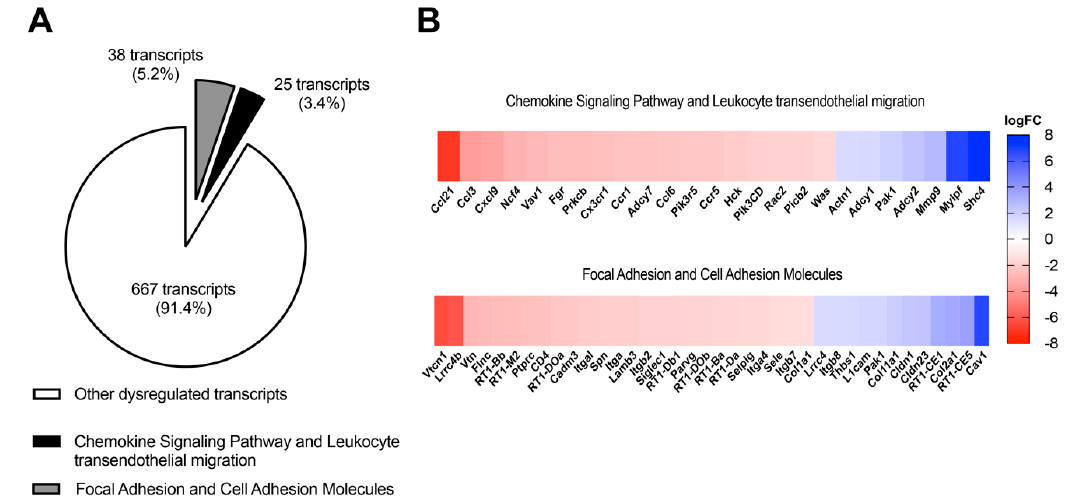
Figure 3. In vivo administration of MRS1754 reduces the transcriptional levels of genes related to chemokine/chemoattractant, cell adhesion, and maturation and function of monocyte/macrophage in the glomeruli of DN rats. ( A ) A total of 14,311 transcripts were analyzed by RNAseq, 730 of them were dysregulated and had a p -adjusted value equal or less than 0.05 in the glomeruli of MRS1754-treated DN rats. Thirty eight dysregulated transcripts were associated with focal adhesion and cell adhesion molecules (CAMs), and 25 transcripts related to the chemokine signaling pathway and leukocyte transendothelial migration were dysregulated. ( B ) Heatmap (logFC) of the top dysregulated transcripts related to the chemokine signaling pathway and leukocyte transendothelial migration and focal adhesion and CAMs in glomeruli of MRS1754-treated DN rats. Downregulated and upregulated genes in the heatmap are represented in red and blue, respectively.